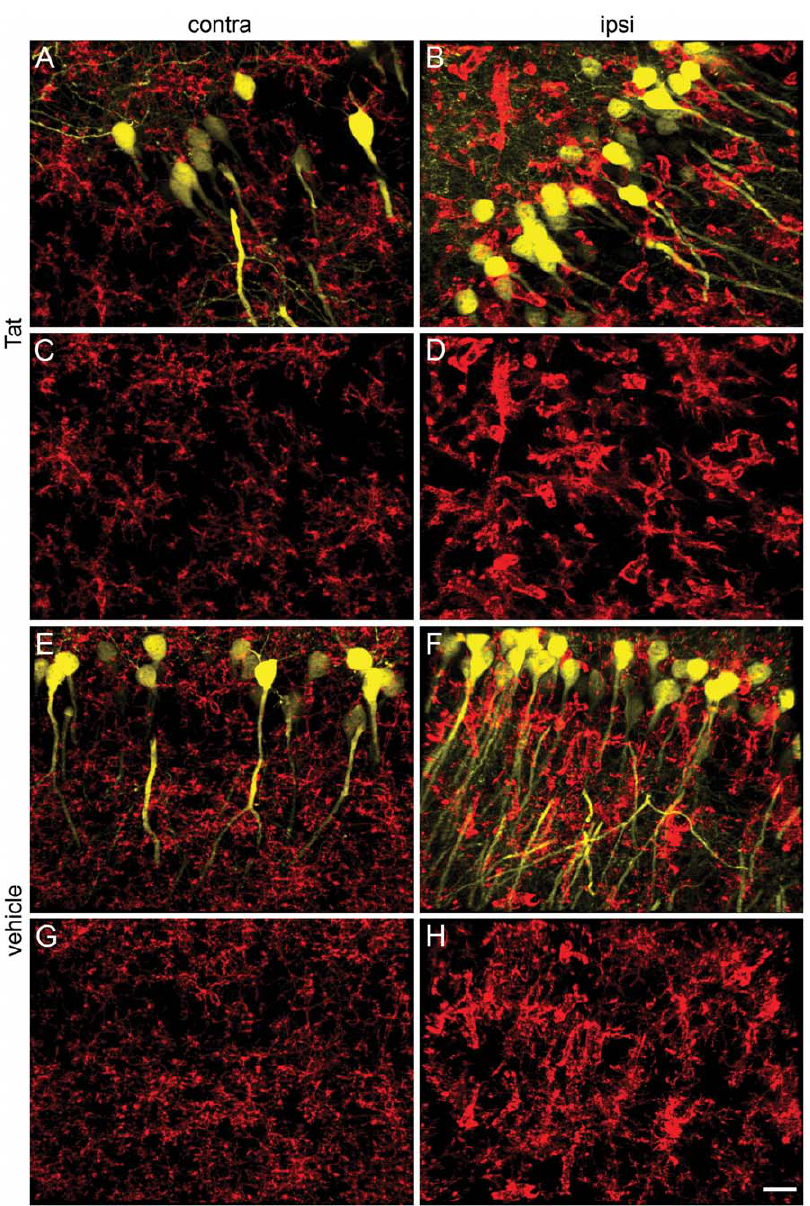
Figure 7. Exposure to Tat alters microglial morphology and spatial relationships with neurons. Montage of thy-1 YFP + neurons (yellow) and CD11b + (red) 24 hr after Tat (Panels B, D, F, H) or control vehicle (Panels A, C, E, G) injection into right hippocampus. Images in Panels A–D are from the CA1–CA2 region about 1 mm away from the vehicle (A, C) or Tat (B, D) ipsilateral to the injection site. Images in Panels E–H are taken from the CA1 region of the contralateral hippocampus of mice injected with vehicle (E, F) or Tat (G, H). Scale bar=20 microns. Note that CD11b + microglia (red) in control vehicle treated hippocampi exhibited a normal resting ramified morphology with comparatively thin processes that bear many small appendages (A, C, E, and G), whereas CD11b + microglia in Tat-treated hippocampi have an activated morphology with much thicker processes and enlarged cell bodies. Some of the hypertrophied processes wrap around YFP + dendrites and cell bodies. Note that the number of YFP + neurons varies between mice. For quantitation (see Results and Figure S2, Panel D), we normalized our data relative to YFP expression in each mouse. For Tat and control groups, n=3 independent replicates.